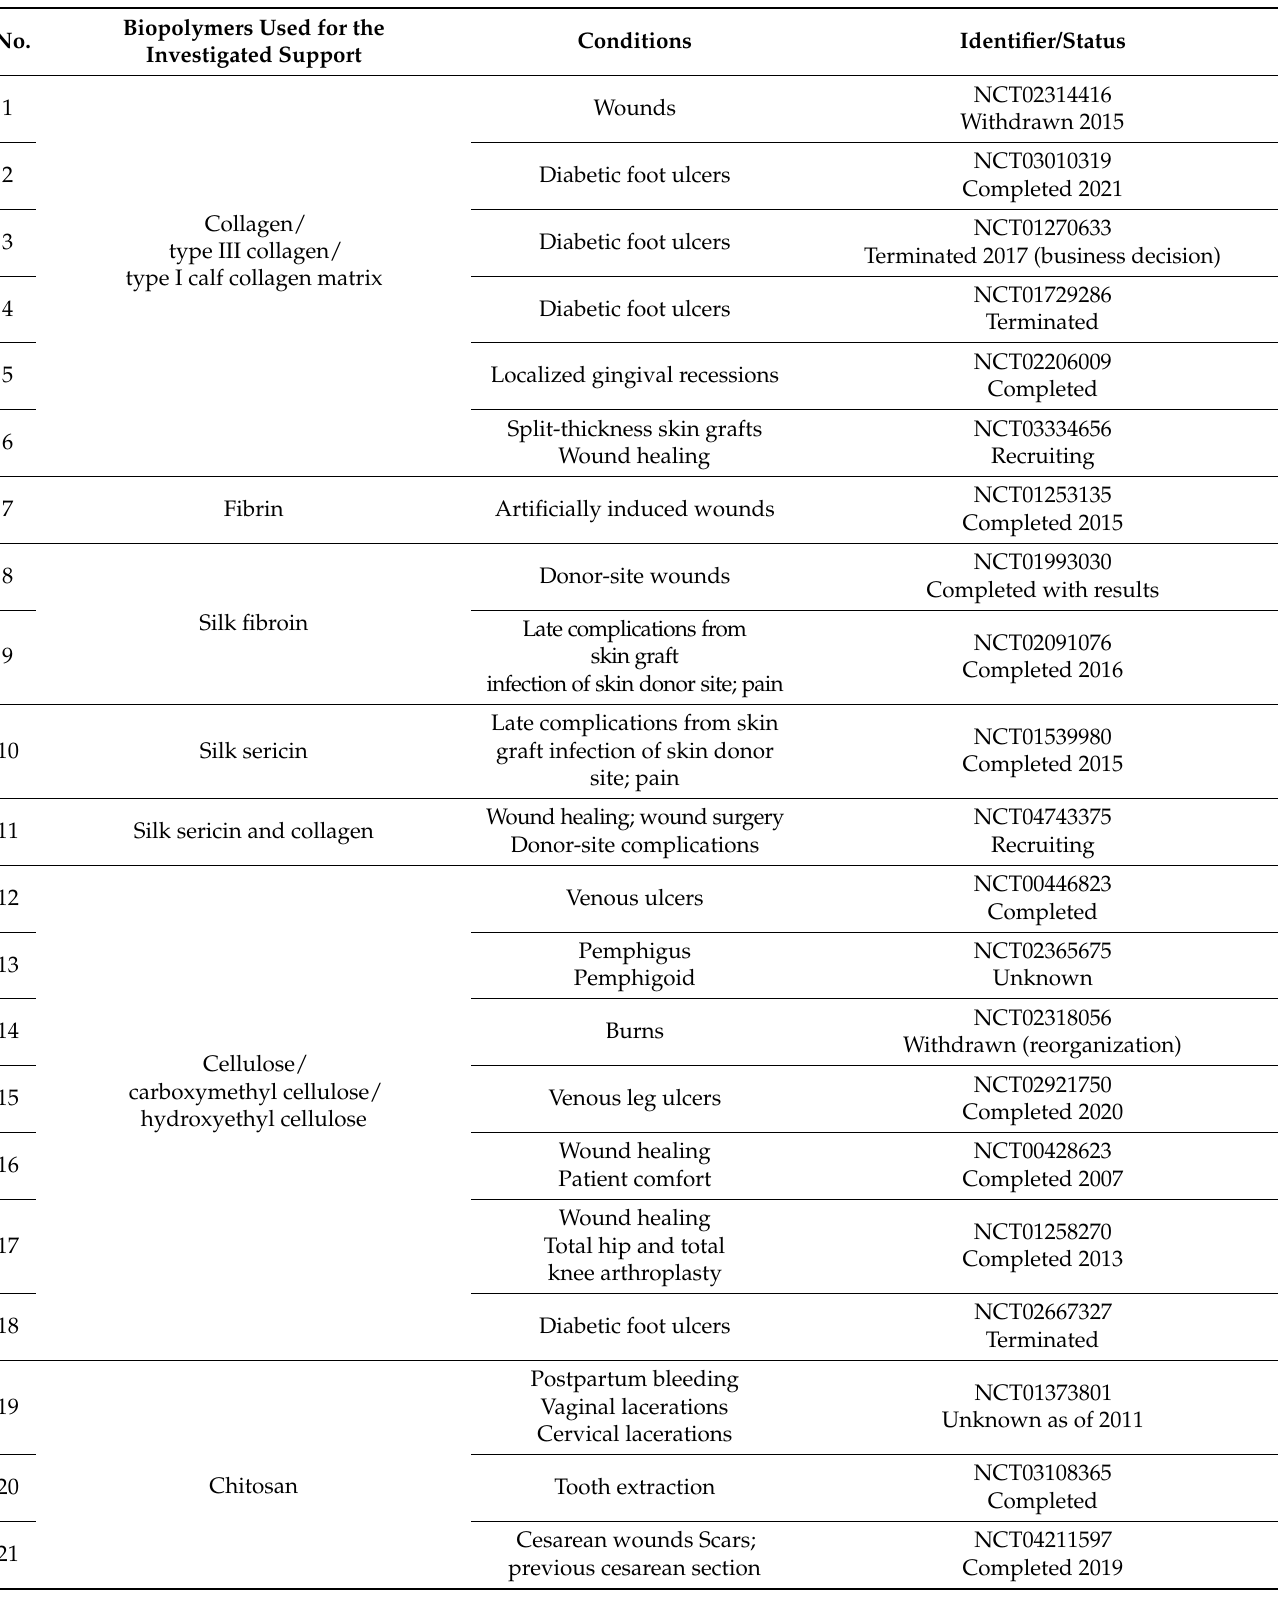
Table 2. Biopolymeric dressings/devices evaluated in clinical trials